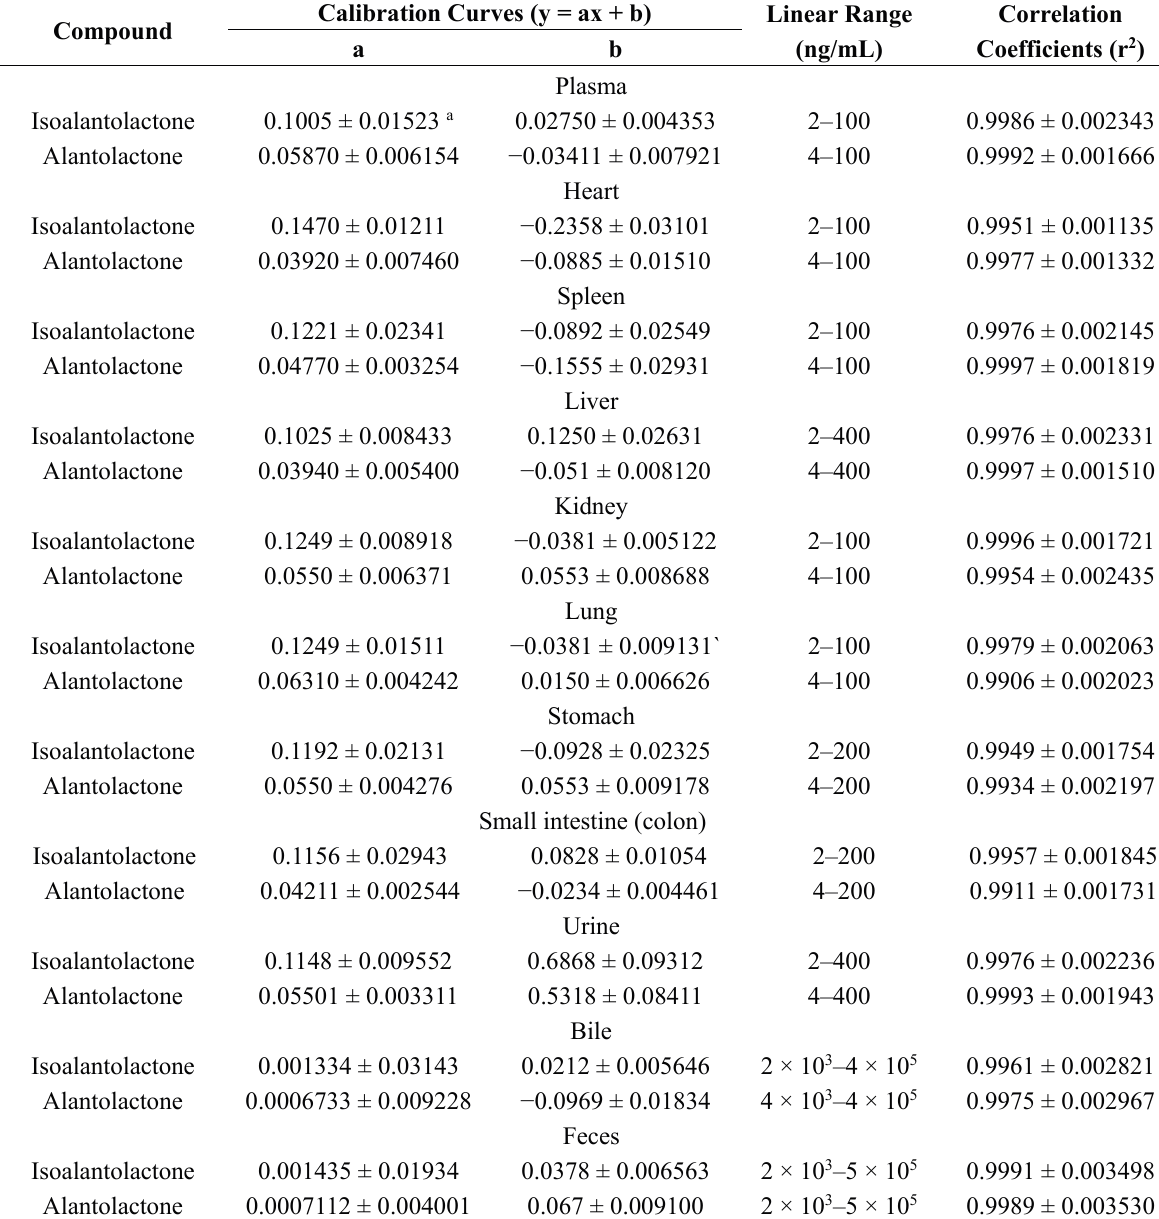
Table 1. Standard curves, correlation coefficients and linear ranges of lactones in tissue samples ( n =